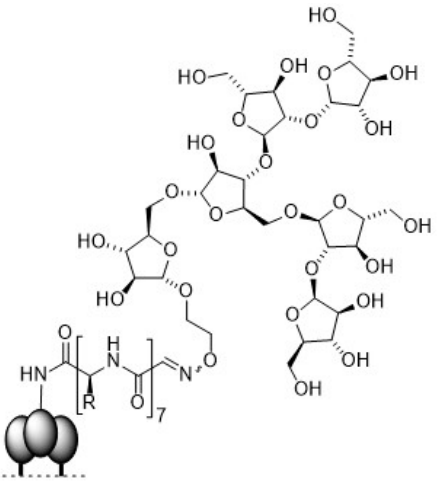
Figure 10. Heptapeptide libraries were displayed on the M13 phage. The glycophage libraries were obtained by periodate oxidation of the N -terminal serine residue on the backbone of the randomized heptapeptides and subsequent oxime ligation with Ara 6 ligands.